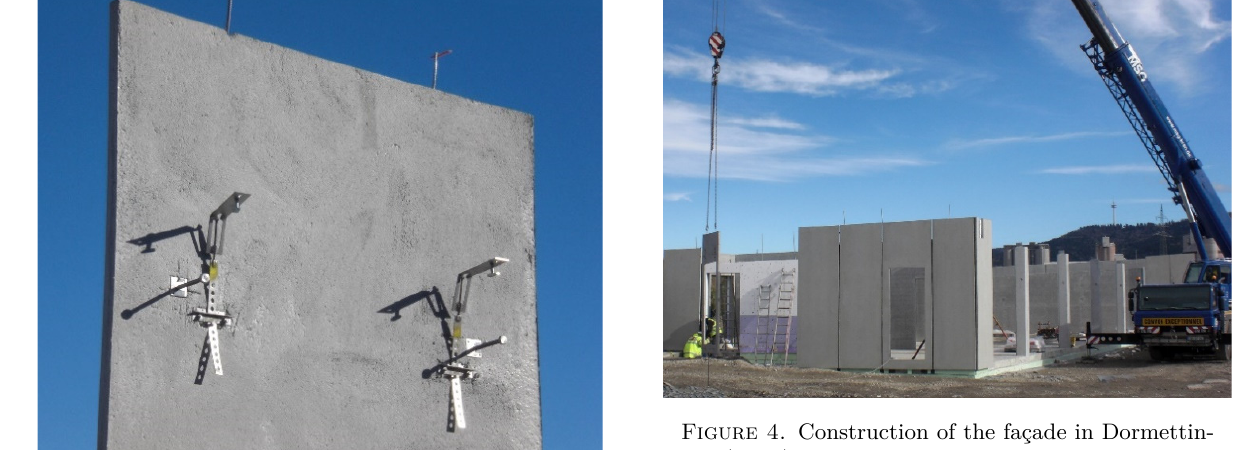
Figure 4. Construction of the façade in Dormettin- gen